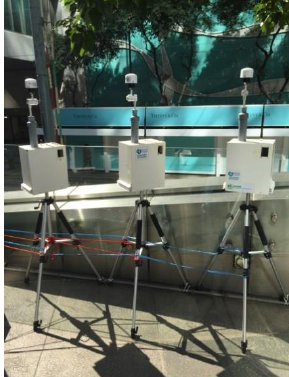
Figure 2. MAS field tests at the Central Air Quality Monitoring Station (AQMS), Hong Kong, China.